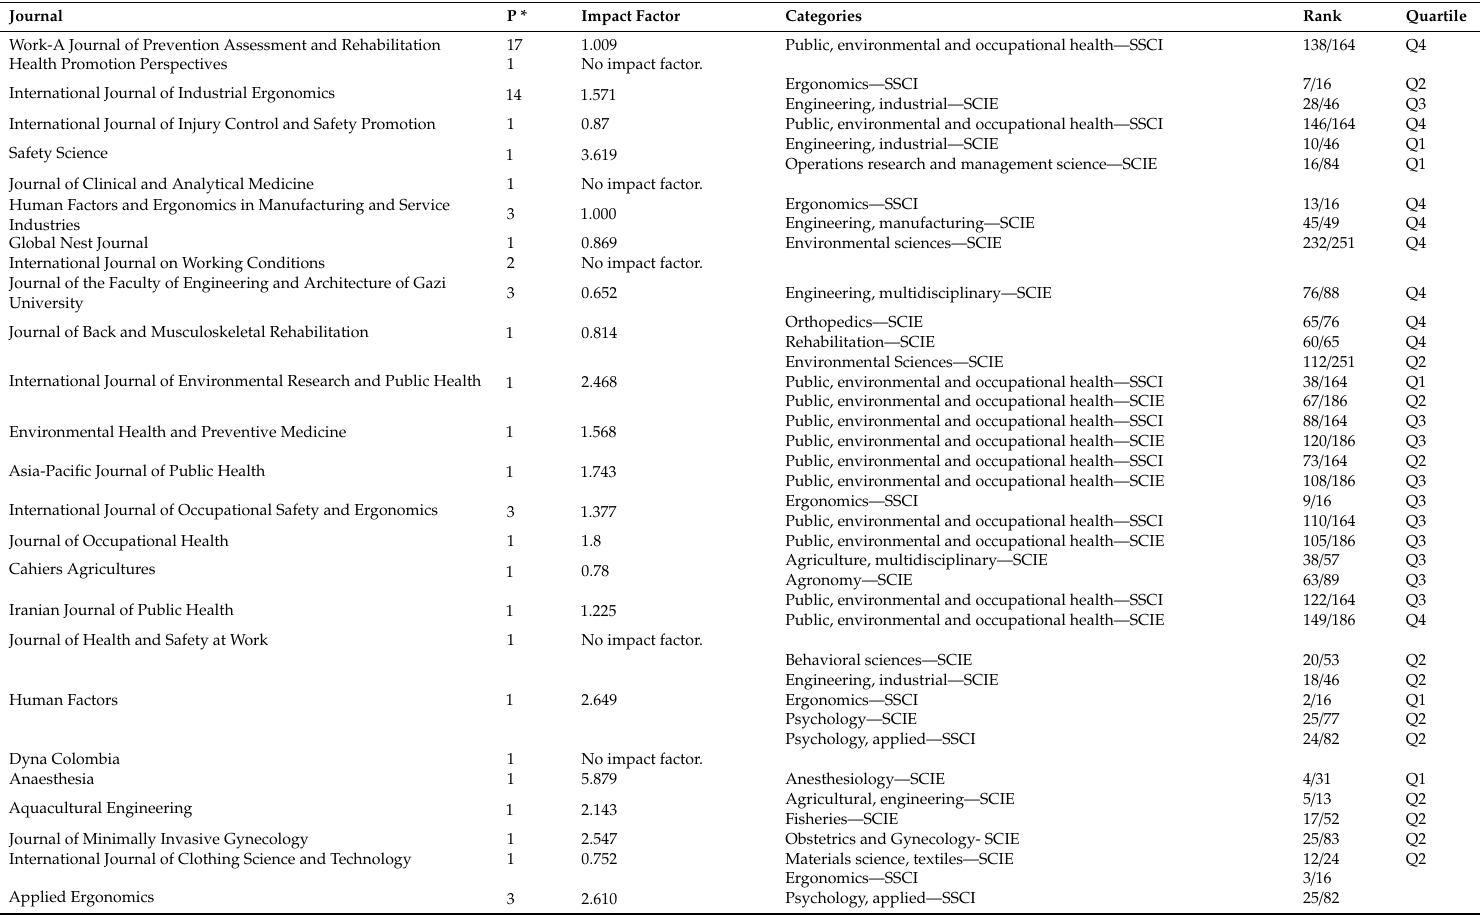
Table 13. Number of publications per scientific journal, knowledge categories (Web of Science), impact factor, rank and quartile (2018).